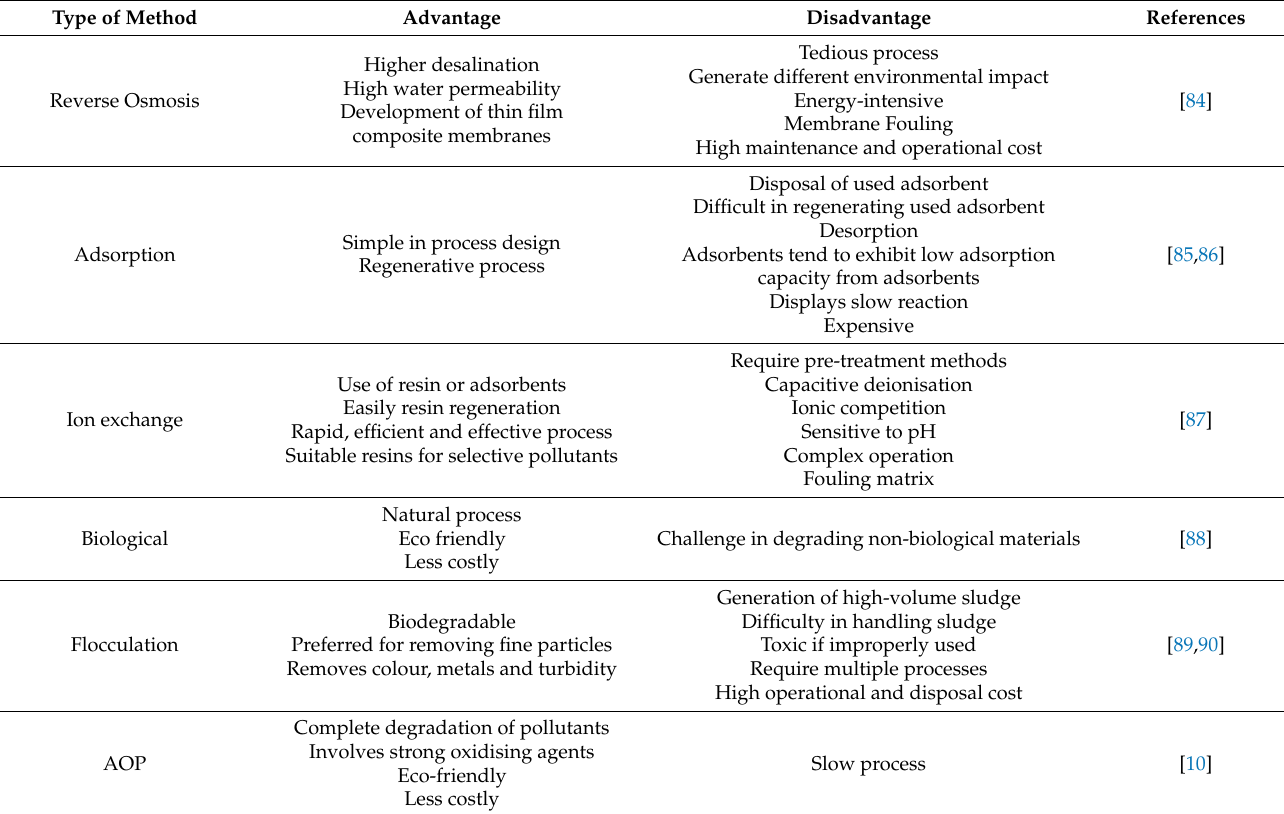
Table 2. List of advantages and disadvantages of wastewater treatment